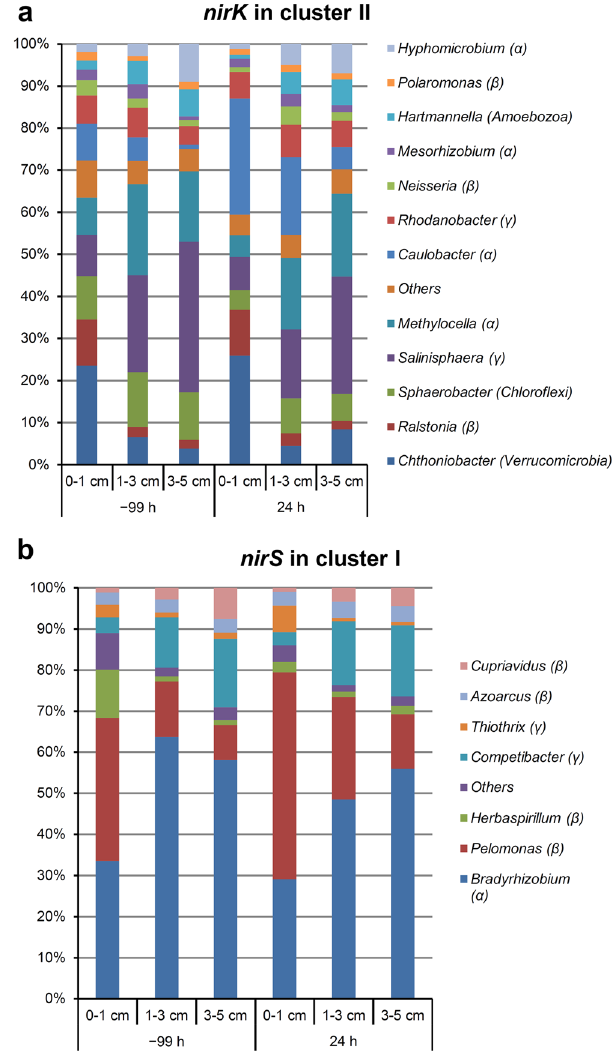
Figure 3. Average relative abundances of nirK in cluster II ( a ) and nirS in cluster I ( b ) sequences affiliated with taxonomic groups at the genus level. Each group is labeled with its genus name, with its phylum or subphylum name in parenthesis. Groups with < 1% sequence number in the 18 soil samples were merged into the “Others” group. α , β , and γ represent alpha- , beta- , and gamma-proteobacteria ,